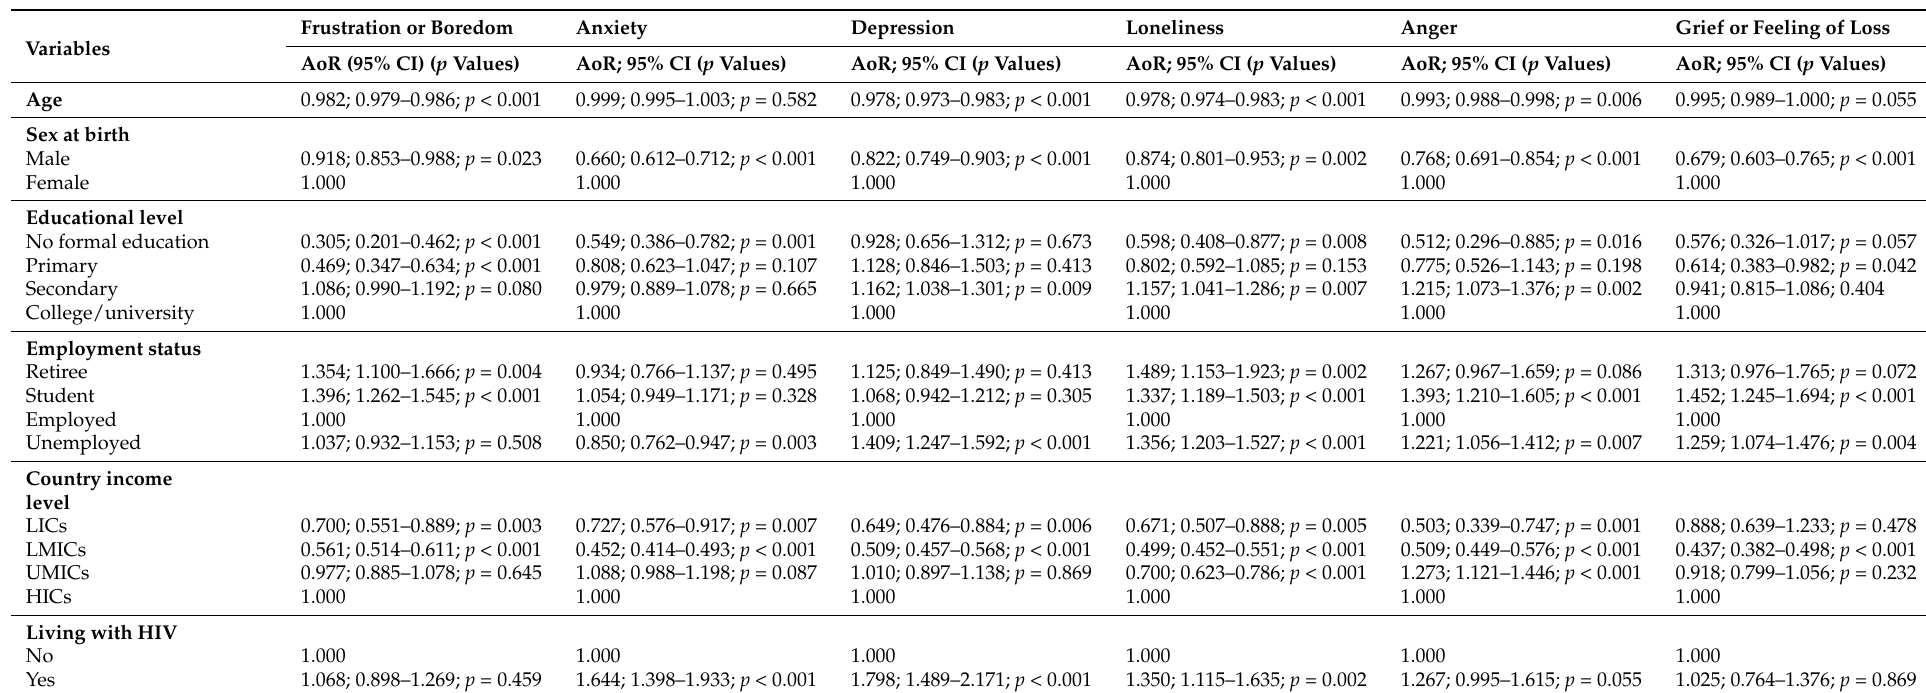
Table 2. Binary logistic regression analysis determining the associations between emotional distress and HIV status of a multi-country sample of study participants (N =